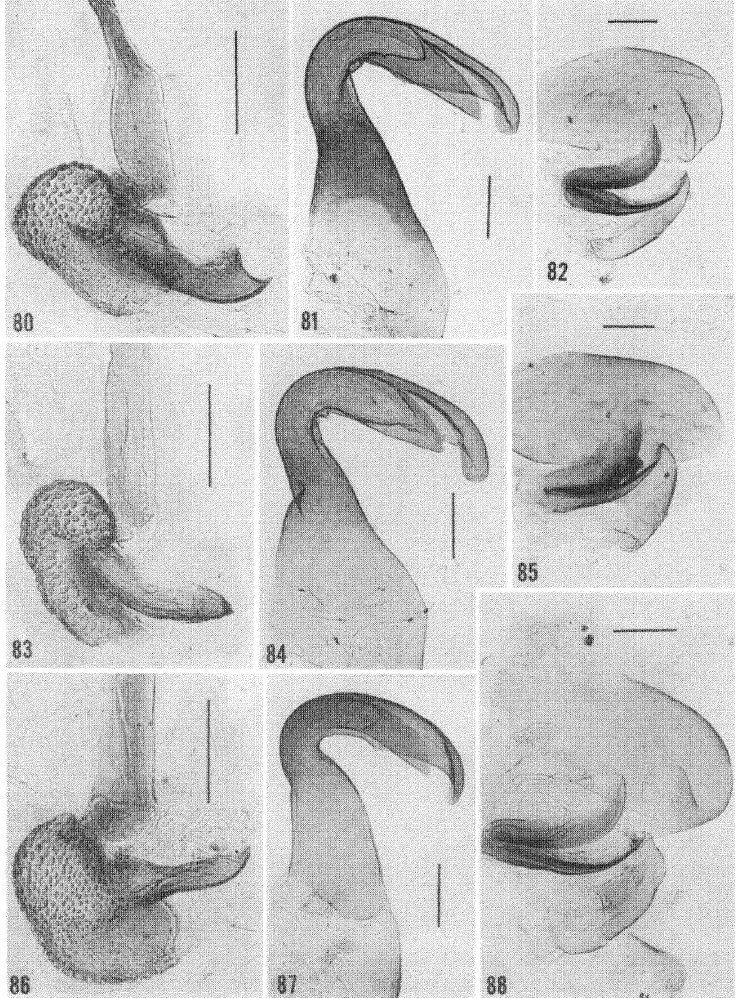
Figures 80 88. Male genital phallomeres of Bantua spp. 80-82. (1403 L). B. robusta (from shown in Fig. 50). 83-85. (148 ANSP). B. robusta (Shelford), paratype of Bantua armigera Rehn. 86-88. (54 BMNH). B. dispar. Distant Coll. (labeled Derocalymma pallipes Kirby). (scale--- 0.2